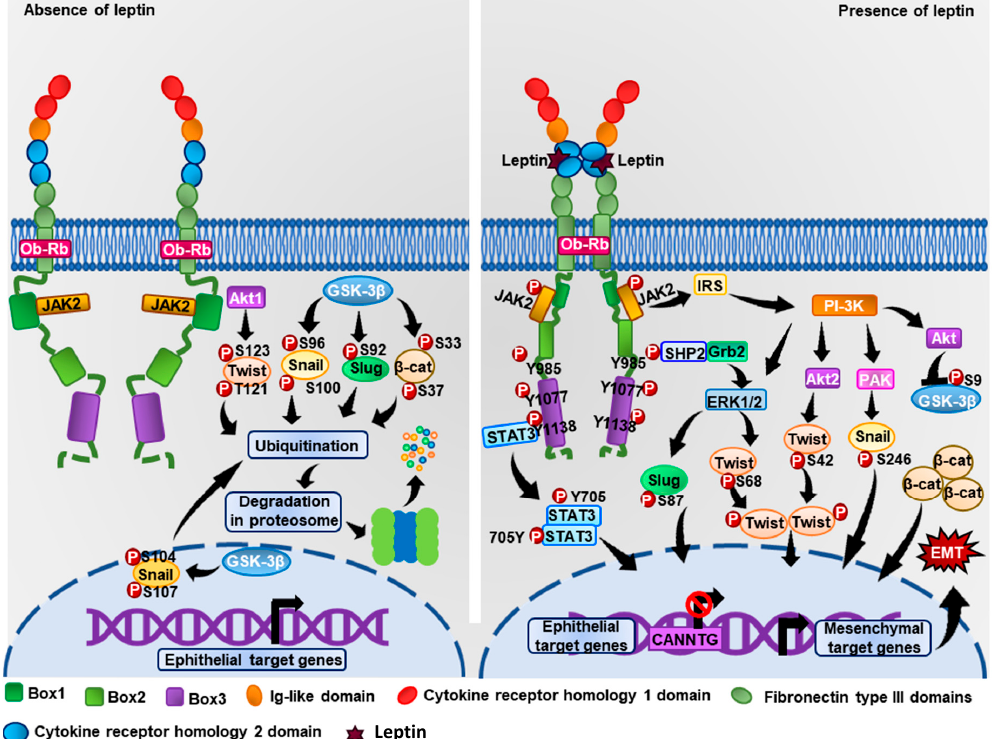
Figure 3. Representative model of leptin-induced EMT signaling. In the absence of leptin, the transcription factors Twist, Snail, Slug, and β -catenin are phosphorylated at specific residues by cytosolic kinases, leading these TFs to their degradation through the proteasomal pathway. When leptin binds to the ObRb receptor, signaling cascades are activated to promote the phosphorylation of EMT-related TFs and induce their translocation from the cytoplasm to the nucleus, where they regulate the expression of EMT-regulators